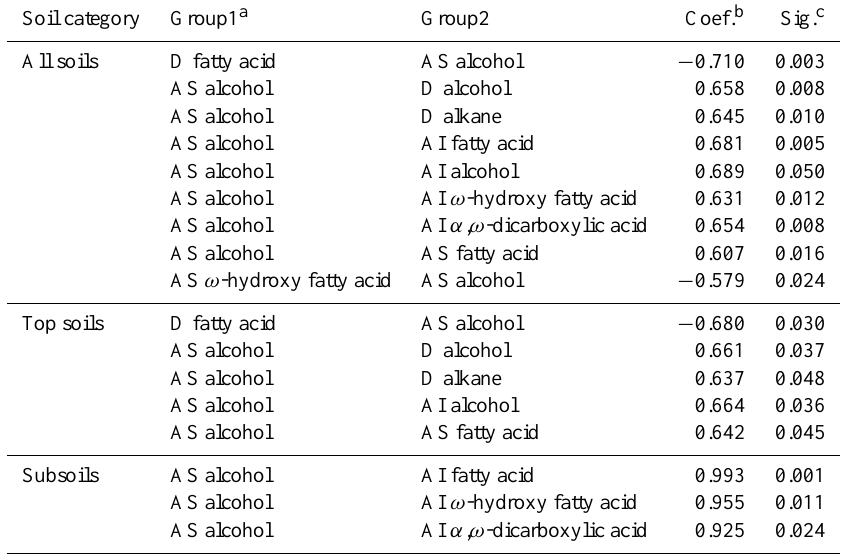
Table 5. Correlation coefficients and significance levels of combinations of two SWR marker groups significantly ( < 0.05) related to SWR based on the quality factor